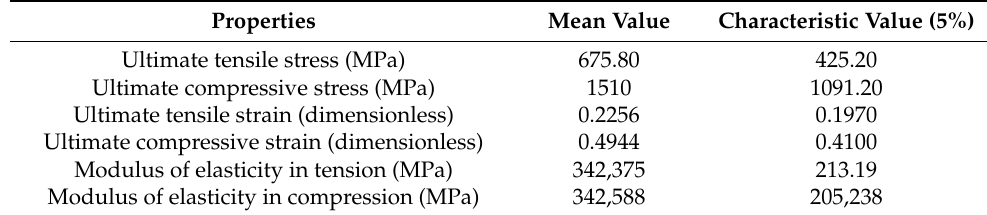
Table 2. Steel bars’ mechanical properties. Source: Luca and Marano